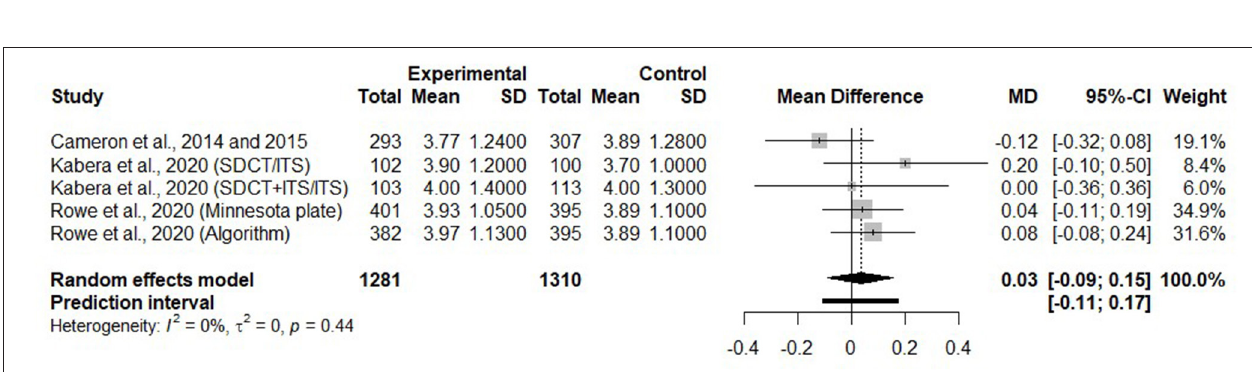
FIGURE 9 | Forest plot illustrating the mean difference in somatic cell counts (on a natural logarithm scale) during the first 4 months of lactation after a selective dry cow treatment approach, in comparison with a blanket dry cow